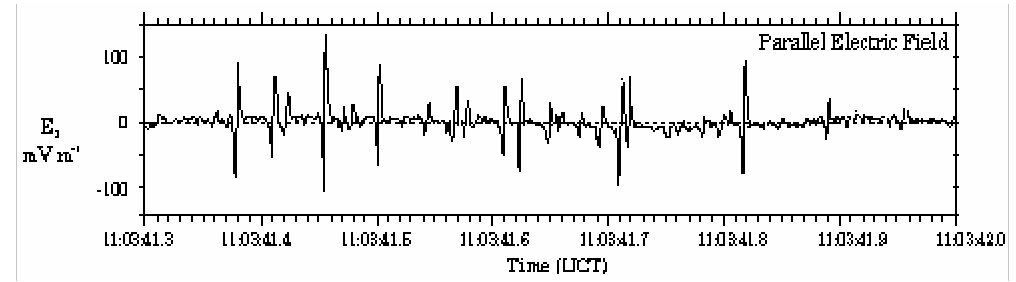
Fig. 1. Example of bipolar electric field pulses parallel to the magnetic field (i.e. z-direction) observed by Polar satellite in the auroral acceleration region (Bounds et al.,